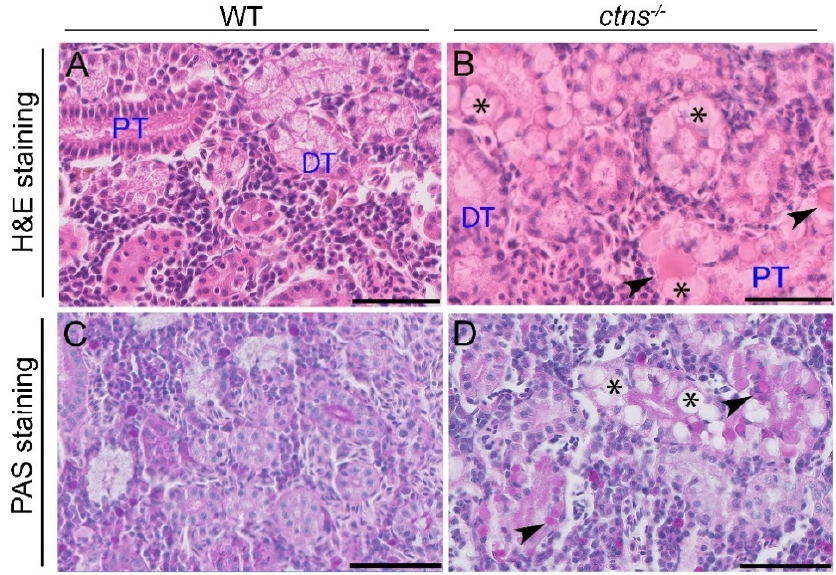
Figure 2. Kidney histology in wild-type and ctns − / − zebrafish. ( A , B ) Representative images of renal tubules of wild-type ( A ) and ctns − / − ( B ) 18-month-old zebrafish. Details of proximal tubules with hyaline-like eosinophilic droplets (black arrowheads) and cytoplasmic vacuoles (*). H&E staining. The scale bars represent 50 µm. ( C , D ) Representative images of the PAS staining of renal tubules of wild-type ( C ) and ctns − / − ( D ) 18-month-old zebrafish. Details of proximal tubules with hyaline-like droplets (black arrowheads) and cytoplasmic vacuoles (*). PAS staining. The scale bars represent 50 µm. PT: proximal tubule; DT: distal tubule.